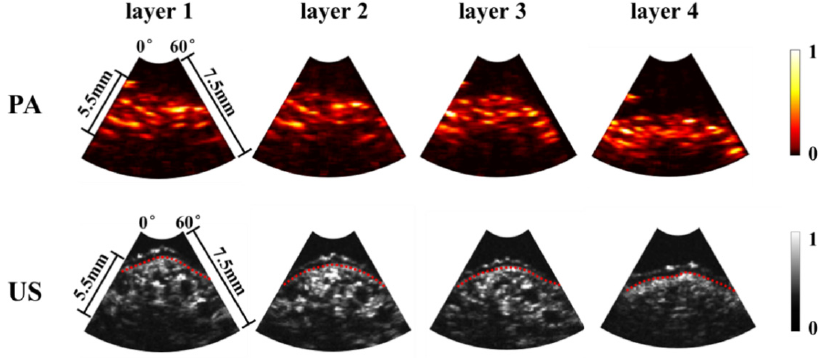
Fig. 5. In vivo photoacoustic (top row) and ultrasonic (bottom row) B-scan images of four typical tongue slices ( (cid:4) 7.5 mm depths are displayed). In the US images, the red dashed line represents the surfaces of the